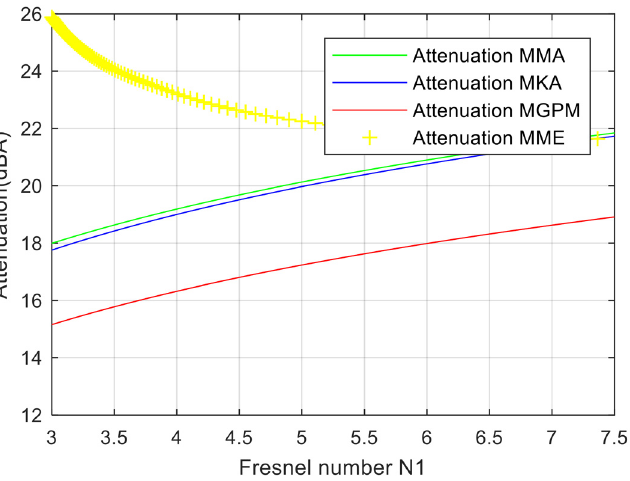
Figure 8. Sound attenuation with modified approaches: Relative humidity = 20%; σ e = 104 kPa · s · m − 2